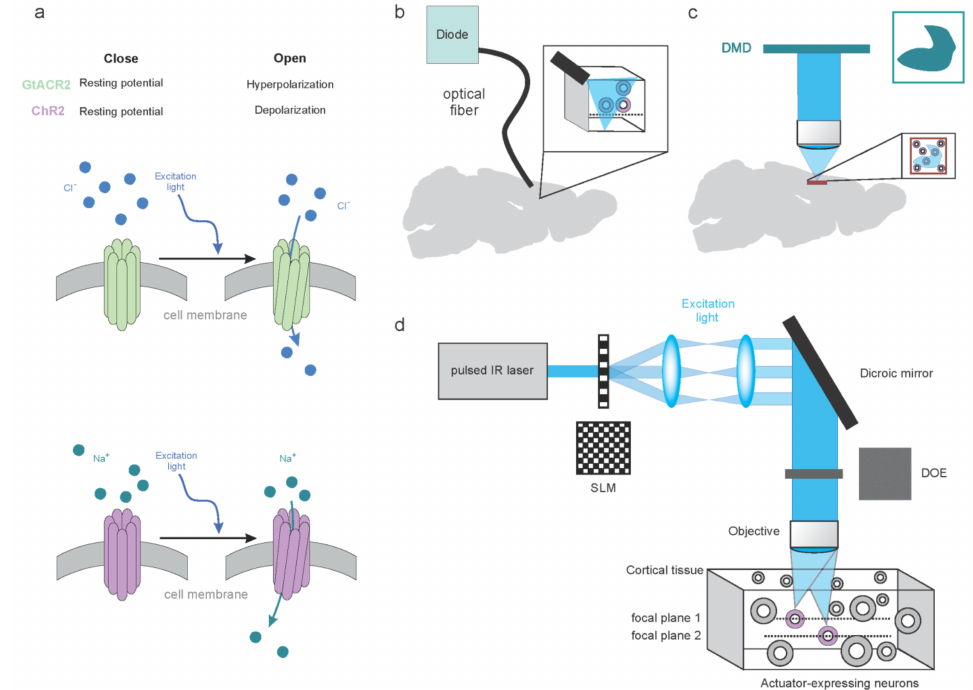
Figure 2. Optical methods to modulate neuronal activity. ( a ) Example of light-gated channels. Upon illumination, the channels open and allow the movement of ions across the membrane based on their selectivity. ( b ) In the simplest configuration, excitation light can be delivered by an optic fiber placed near the target area. ( c ) A more precise control of the illumination can be obtained relying on DMDs which create pattern of light based on the on–off configuration of the individual